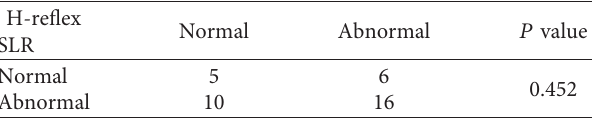
Table 9: Association between abnormal SLR and abnormal H-